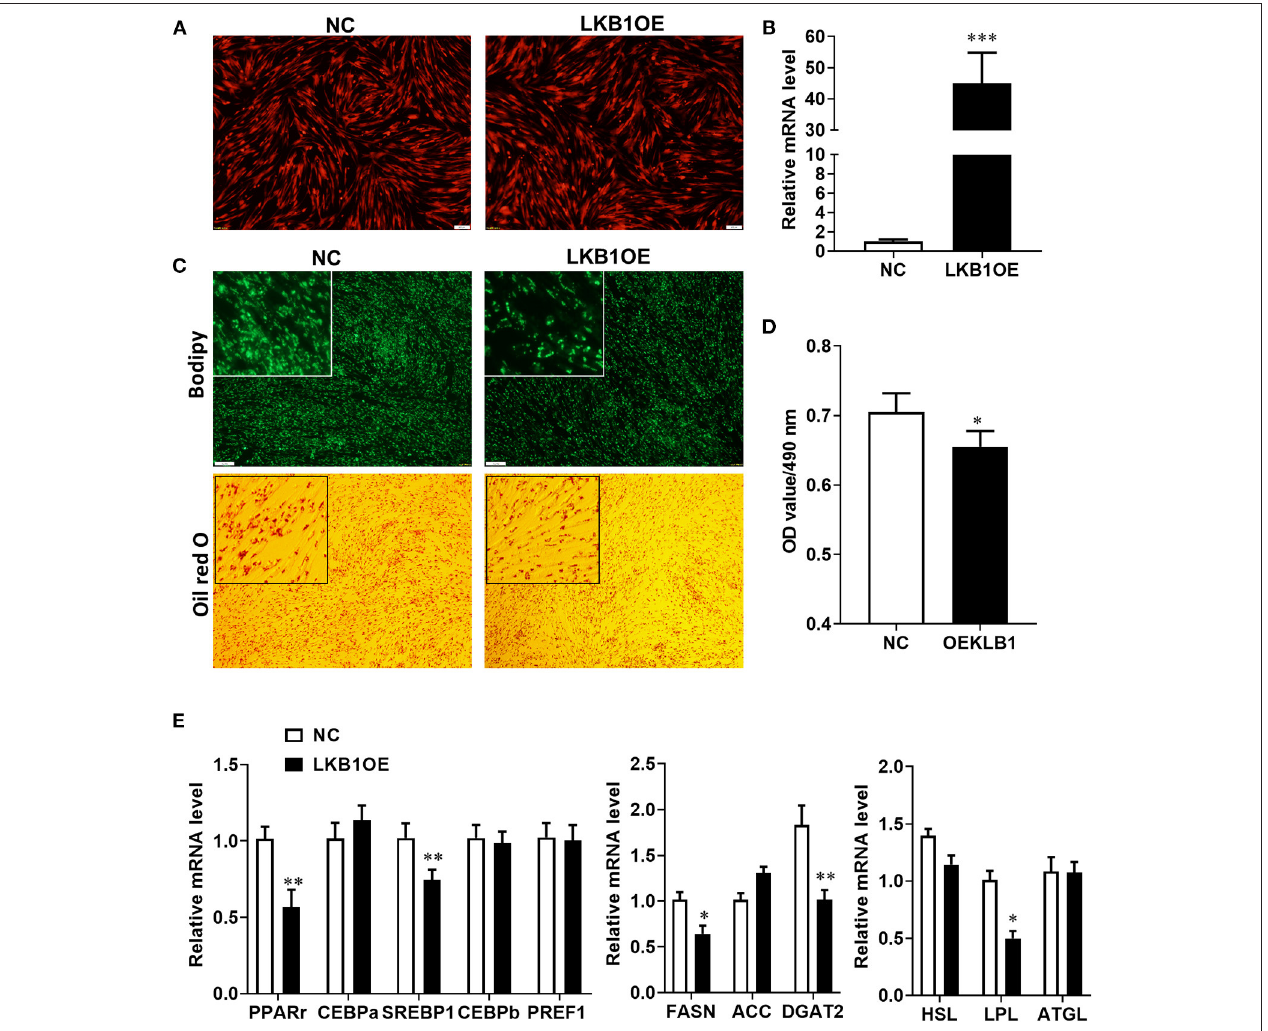
FIGURE 5 | Overexpression of LKB1 inhibits intramuscular adipocyte lipid accumulation and downregulates mRNA level of adipogenic-related genes. (A) The images of intramuscular preadipocytes infected by control or overexpressed LKB1 adenovirus. (B) The overexpression efficiency of LKB1 in intramuscular adipocyte mediated by adenovirus. (C) The images of mature intramuscular adipocytes stained by bodipy and oil red O dye. (D) Quantitative analysis of oil red O staining signal was indicated by absorbance at 490nm. (E) The mRNA level of adipogenic transcription factors ( PPAR γ , C/EBP α , C/EBP β , and PREF1 ), TG synthesis genes ( FASN , ACC , and DGAT2 ), and TG lipolysis genes ( HSL , LPL, and ATGL ) between control and LKB1OE groups post-adipogenic induction. * P < 0.05, ** P < 0.01, *** P < 0.001. Scale bar: 100 µ m. LKB1, liver kinase B1; FASN, fatty acid synthase; ACC, acetyl-CoA carboxylase alpha; DGAT2, diacylglycerol acyltransferase,